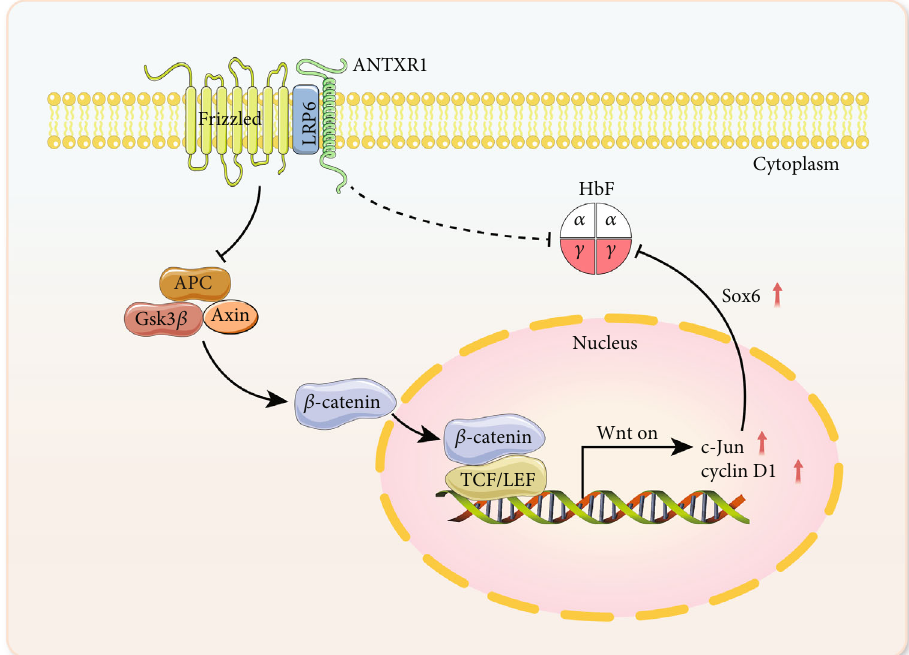
Figure 7: Molecular mechanisms by which ANTXR1 regulates γ -globin expression via the Wnt/ β -catenin signaling pathway. The interaction of ANTXR1 with LRP6 may inhibit the activity of the β -catenin destructive complex consisting of Axin, APC, and Gsk3 via Frizzled. β -Catenin is then free to translocate to the nucleus where it binds to the TCF/LEF transcription factors, thereby promoting the transcription of target gene c-Jun , which, in turn, activates the expression of SOX6, a repressor of γ -globin genes, thereby inhibiting the expression of γ -globin